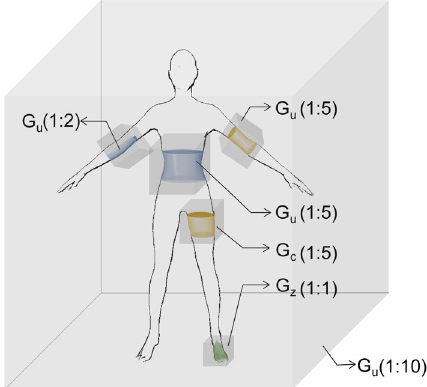
Fig. 7 Various symmetry found in human body parts for 1:1, 1:2, 1:5, and 1:10 printing scales (each cube represents the maximal printing volume of the 3D printer in its printing